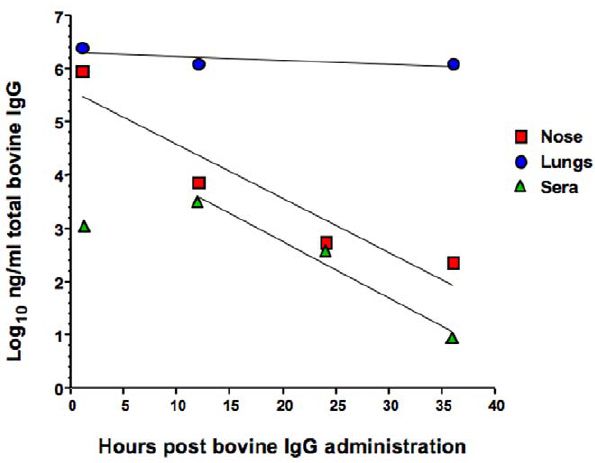
Figure 9. Half-lives of intranasally-delivered bovine IgG in the nose, lungs and serum. The bovine anti-PR8 IgG preparation (1 mg) was administered in a volume of 50 m l by the i.n. route to anesthetized mice. At 1, 12, 24 and 36 hr post-administration, mice were killed and bovine IgG was detected by capture ELISA in nasal turbinate and lung homogenates and in sera. The total amount of Ab was determined by reference to a standard curve. Linear regression analysis was used to calculate the half-lives of bovine IgG in the different sites. The data are representative of two experiments.